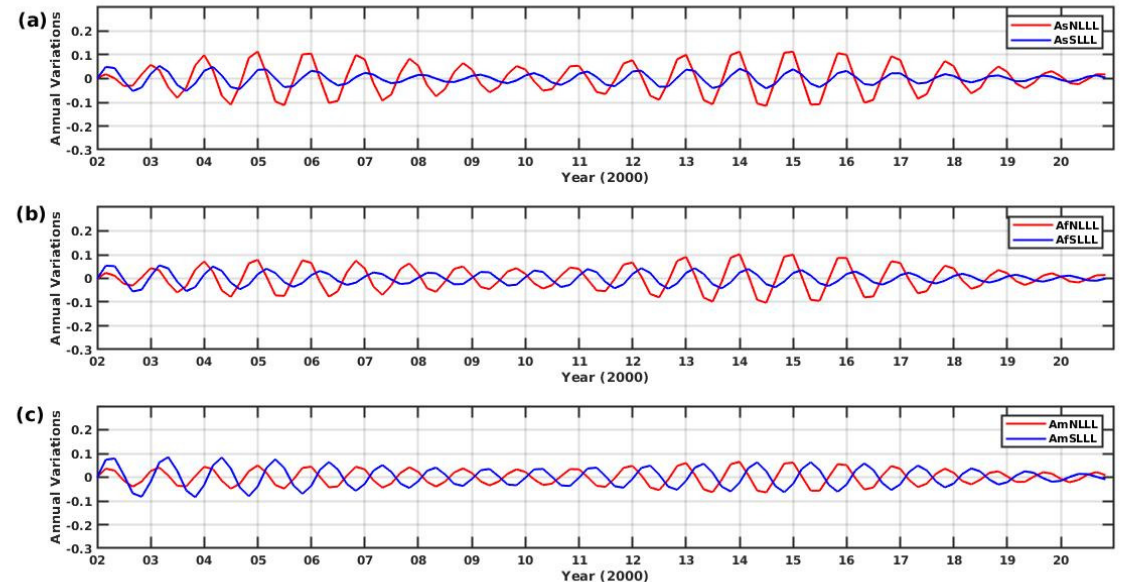
Figure 5. Similar to Figure 2a for ( a ) Asian, ( b ) African, and ( c ) American regions. Figure 6 describes the semiannual variations for the Asian, African, and American sectors from 2002 to 2020. The semiannual variations exhibited almost similar trend in the three longitudinal sectors. The northern low-latitudes, in the African and American regions, showed slightly higher amplitude as compared with the southern counterparts. The maximum (minimum) amplitude of the semiannual variations occurred during the years 2004–2005 (2019–2020). Moreover, these semiannual variations remain hemispherically symmetric at all the longitudes.